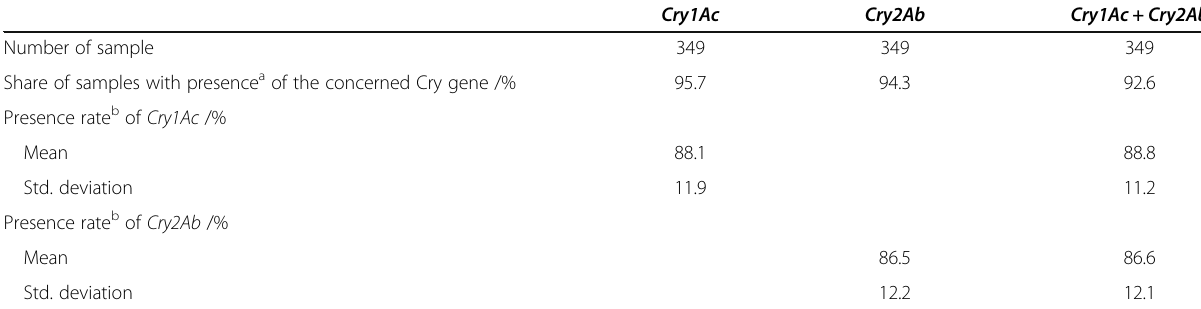
Table 3 Bt status of seeds in samples from fields of Bt cotton